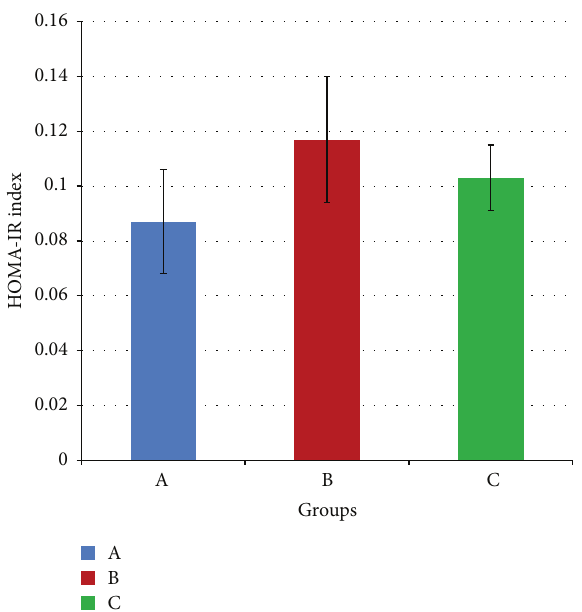
Figure 6: Mean HOMA-IR index of rats in groups A, B, and C at the end of the four-week treatment period. Group A: control (HSD/HFD); group B: stress + HSD/HFD; group C: stress + GA + HSD/HFD. Abbreviations: GA: glycyrrhizic acid, HSD: high- sucrose diet, and HFD: high-fat